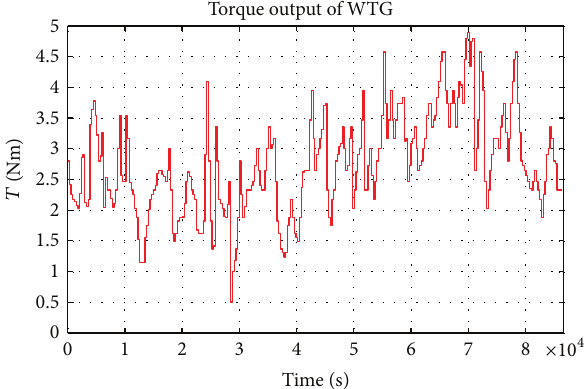
Figure 13: Torque output of simulated wind turbine.